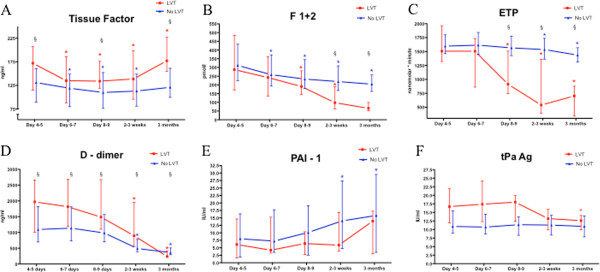
Circulating levels of tissue factor, F1+2, D-dimer, PAI-1 activity, tPA antigen and ex vivo ETP measured 4–5 days, 6–7 days, 8–9 days, 2–3 weeks and 3 months after the AMI. Median values with 25th, 75th percentiles are given. § refers to p-value < 0.05 for differences between the groups at the various time points, and * indicates p-value <0.05 for intragroup differences from day 4–5 to the subsequent time points. F1+2; prothrombin fragment 1+2, ETP; endogenous thrombin potential, PAI-1; plasminogen activator inhibitor 1 activity, tPA; tissue plasminogen activator antigen.